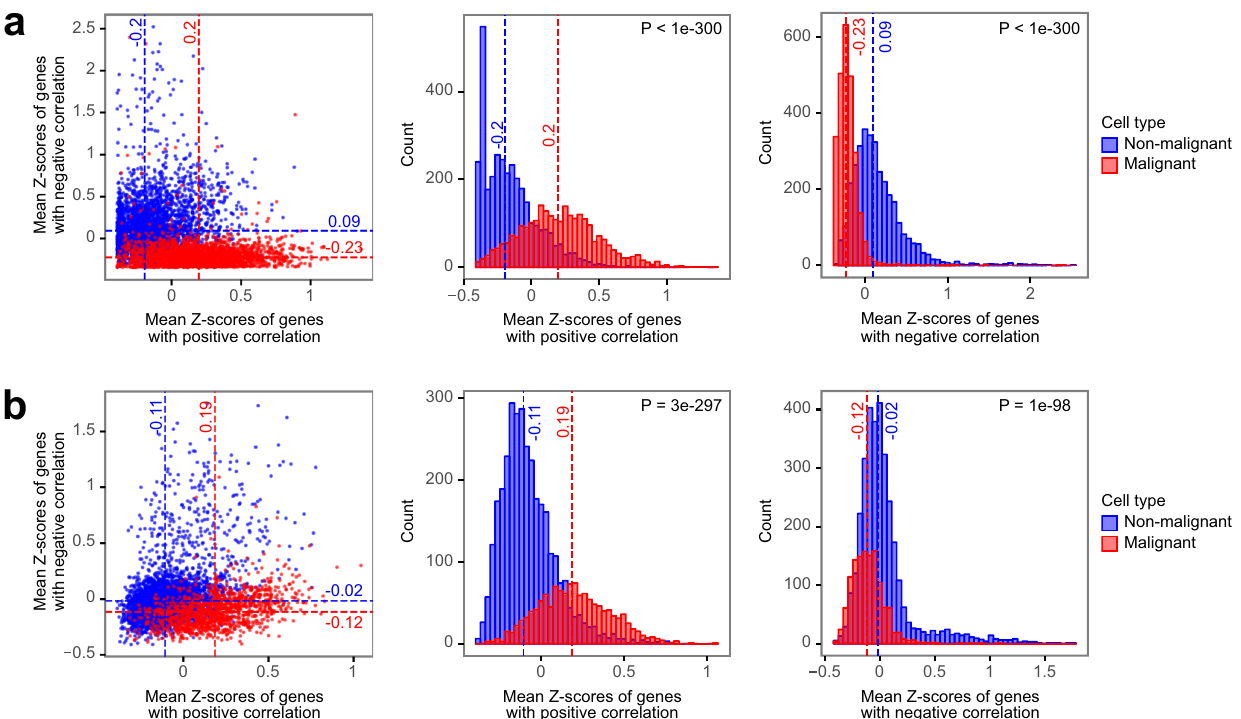
Fig. 6 Validation of PUREE ’ s features using single-cell RNA-seq data. a , b Comparing the expression of PUREE gene features in malignant and non- malignant cells in ( a ) head and neck cancer cells from Puram et al. 39 and ( b ) melanoma cells from Tirosh et al. 40 . Malignant and non-malignant cell labels were obtained from the original publications. Genes were separated into groups of positive (top 20%) and negative (bottom 20%) purity-vs-expression correlation in TCGA data averaged across cancer types. The dashed red and blue lines indicate medians of malignant and non-malignant cells ’ z-scores distributions respectively. P -values are calculated using the Mann – Whitney U rank test Feature selection . We used Lasso regression to reduce the number of input fea- tures in PUREE. During the fi rst step, we selected features relevant to both low and bottom and top-20% purity values, respectively. These two resulting feature sets were intersected, resulting in 167 genes. Next, we further iteratively selected fea-